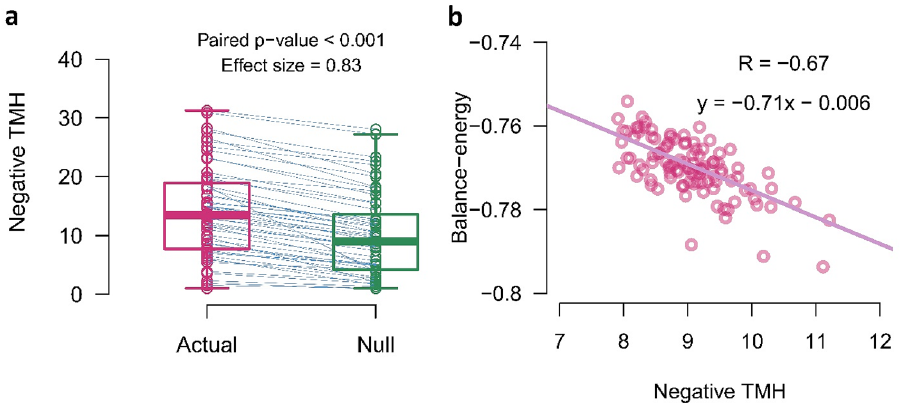
Figure 4. Negative hubness and balance-energy. (a) Matched-pairs analysis of negative TMHs between actual networks and their correspondent null-networks. Vertical boxes indicate median and interquartile ranges and blue lines connect paired points. P-value and effect size of Wilcoxon signed-rank test are reported in the figure. (b) A negative correlation between the negative TMHs and the balance-energies of simulated networks. Circles denote simulated signed networks and the violet line indicates the linear fitted function to them. TMH tendency to make hub, R Pearson correlation